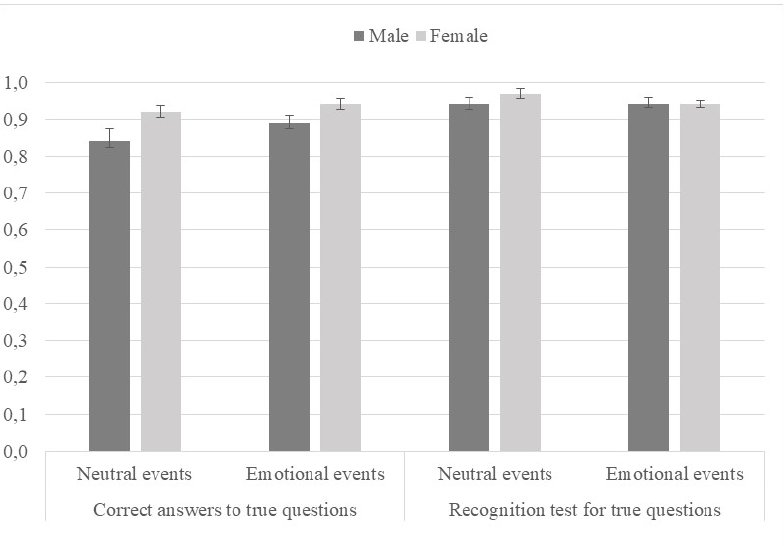
Figure 2. Proportion of correct answers to true questions and for the recognition test for true questions (a week later) by type of event for men and women. Error bars represent standard error of the mean.